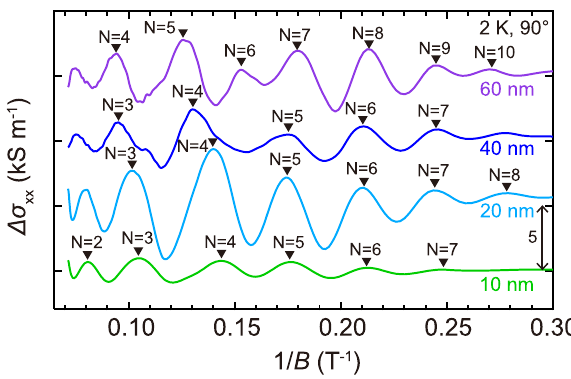
Fig. 9 Background-subtracted SdH oscillations at 2 K with B (3.3 T < B < 14 T). The magnetic fi eld was applied in the out-of-plane [001] direction of the SrTiO 3 substrates for the SrRuO 3 fi lms with t = 10, 20, 40, and 60 nm. The black triangles show peak